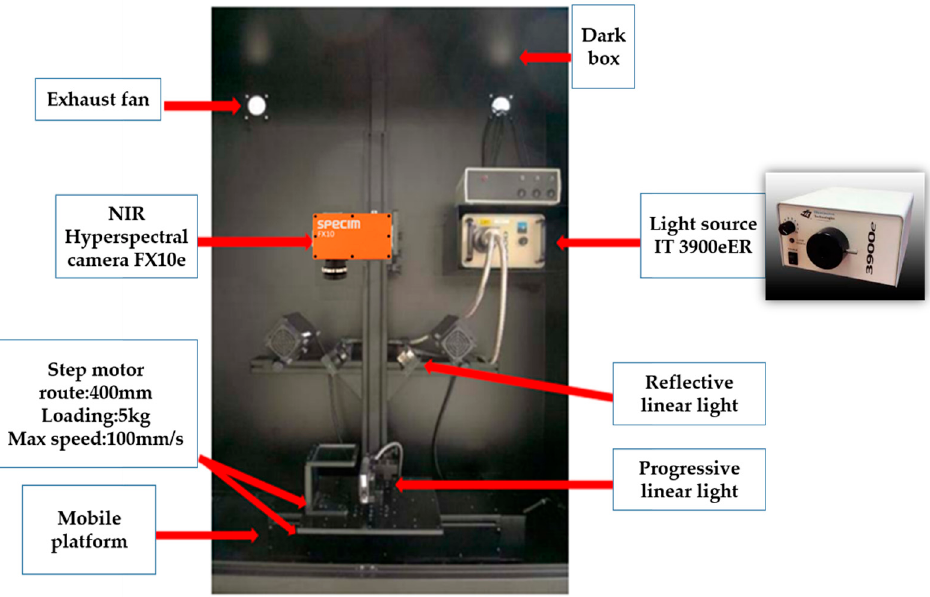
Figure 1. Hyperspectral imaging system.